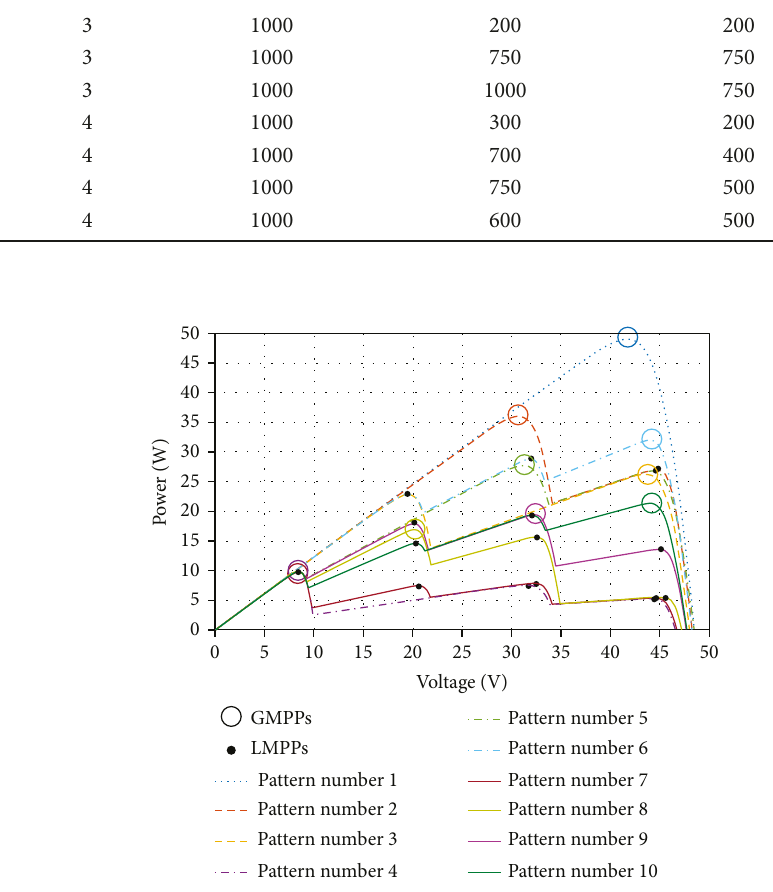
Figure 7: P - V curves of the 10 PSC patterns in the